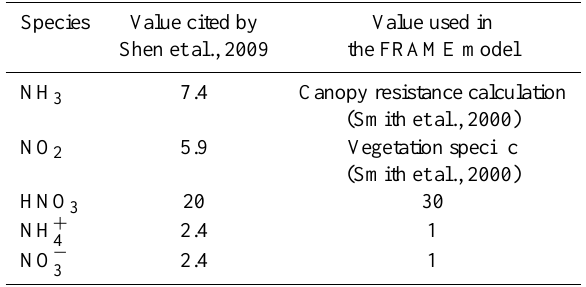
Table 2. Dry deposition velocities of N-compound pollutants cited in Shen et al. (2009) and in the FRAME model (unit: mms − 1 )